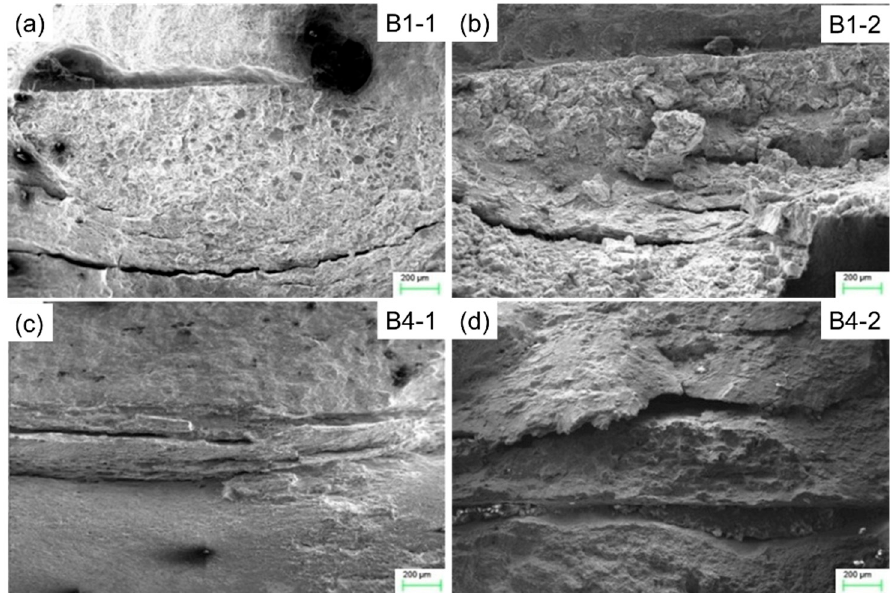
Figure 18. The micro-fracture surface morphologies in the heat affected zones (HAZs) of SSRT specimens: ( a ) B1-1, ( b ) B1-2, ( c ) B4-1 and ( d ) B4-2.